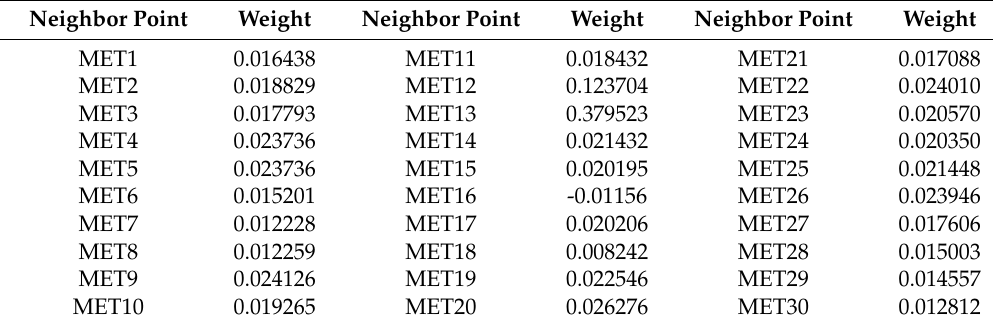
Table 2. Weights of 30 METs for solar farm “A”.